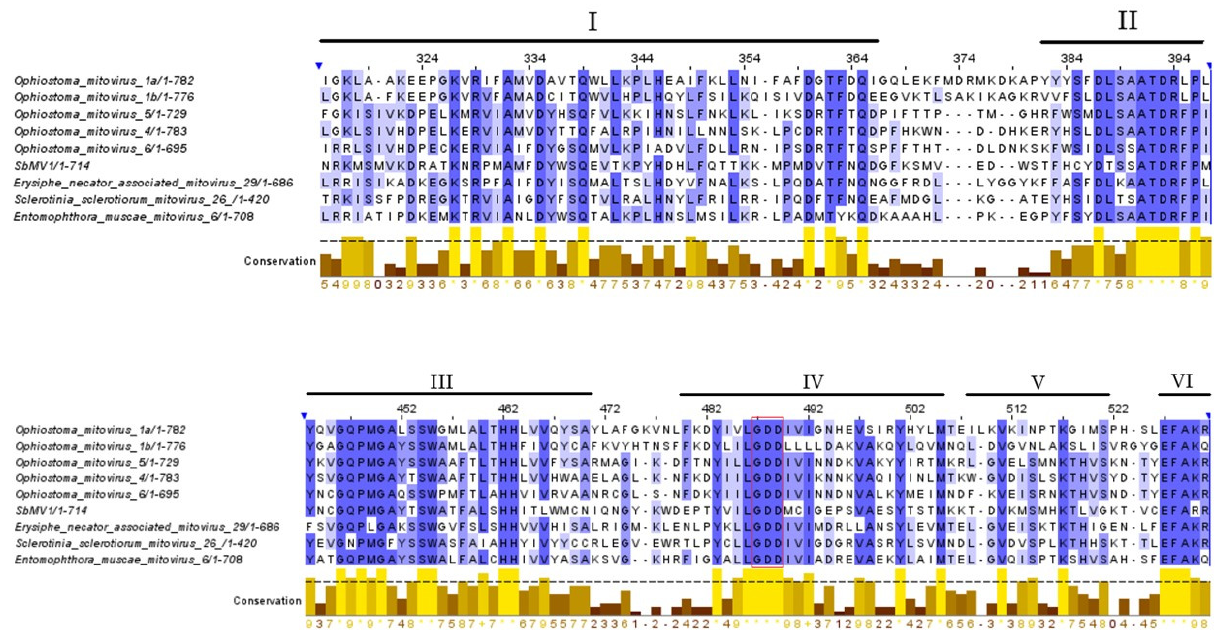
Figure 4. Comparison of amino acid sequence motifs in the RdRp-like proteins encoded by mito- chondrial viruses and the proposed novel species Starmerella bacillaris mitovirus 1 (SbMV1). The alignment was made with the CLUSTAL Omega program. Conserved motifs (from I to VI) are indicated by lines above the sequence alignment. Identical aa residues are color-highlighted with blue; conserved and semi-conserved amino acid residues are color-highlighted with lilac and light lilac, respectively. The hallmark viral polymerase GDD tripeptide conserved domain is indicated by the red rectangle.